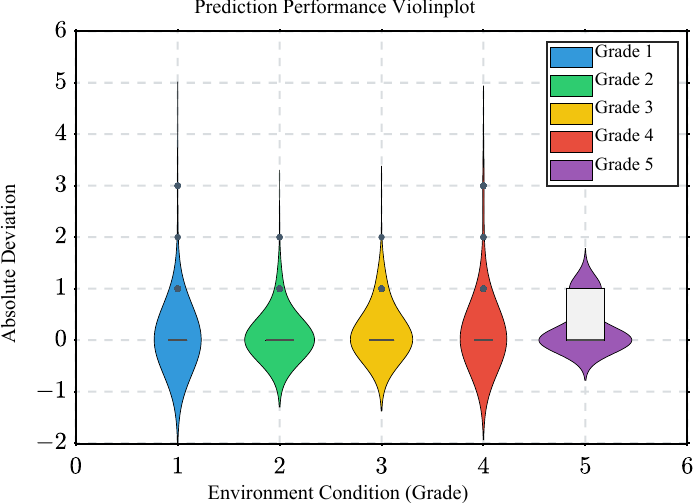
Figure 9. The prediction performance.